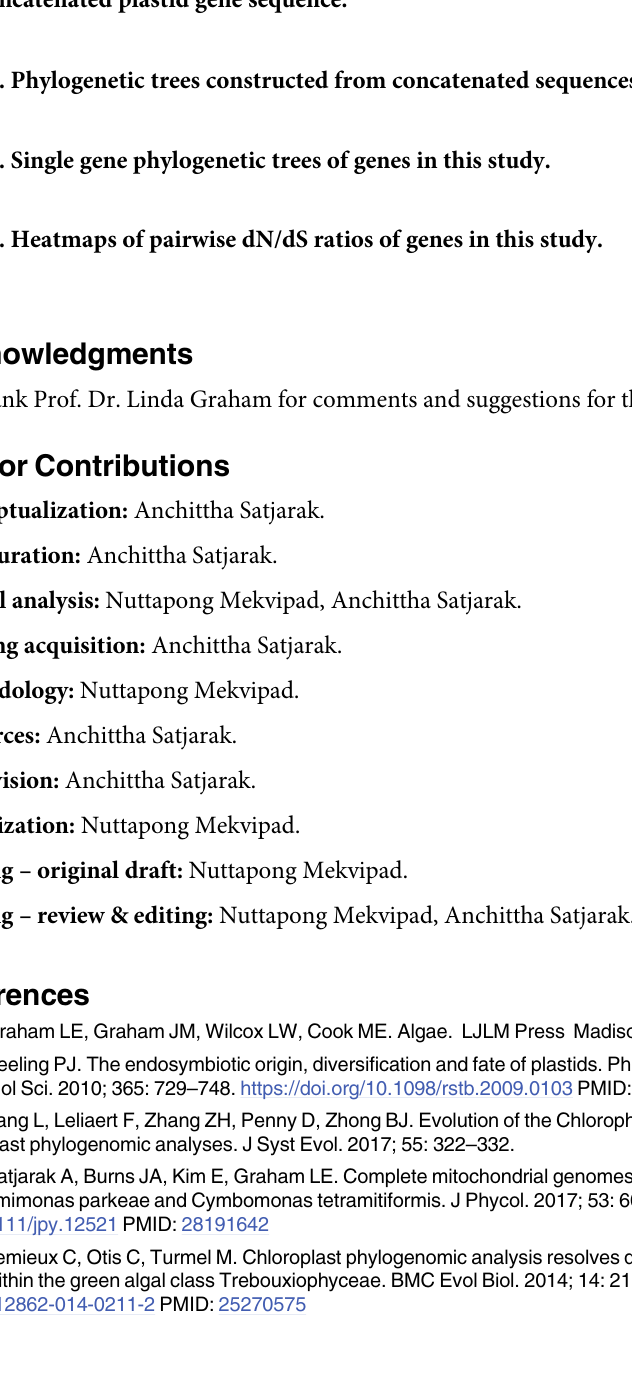
S2 Table. Alignment length and nucleotide substitution model used for phylogenetic anal- ysis of sequence of each gene. S3 Table. Monophyly of known clades resolved from phylogenetic estimations. Bootstrap value cut-off is � 80 in Maximum Likelihood framework or � 0.8 in Bayesian Inference. S1 File. Phylogenetic trees constructed from concatenated mitochondrial gene